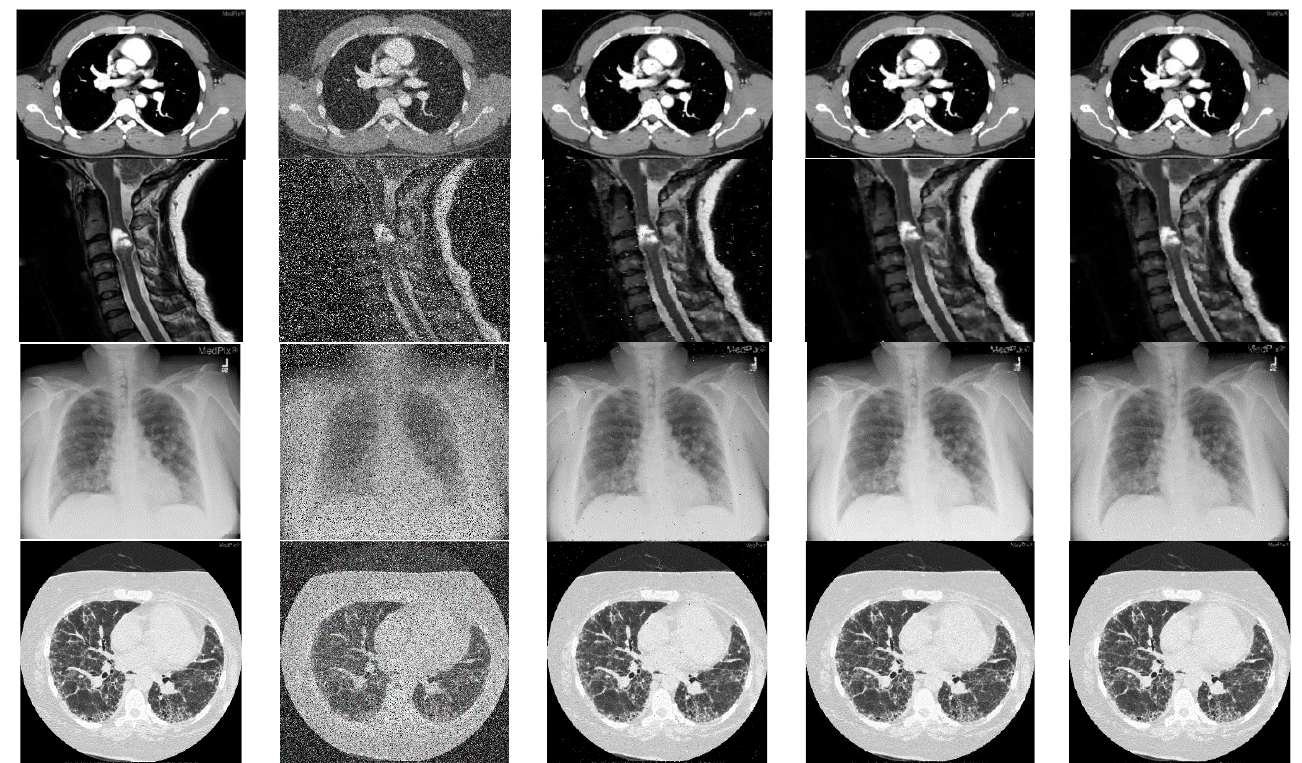
Figure 10. Shows image restoration results on medical image dataset. 1st column are the original images from MedPix database, 2nd column are the noisy images with 40% RVIN, third column shows de-noised results using AFIDM filter, fourth column shows de-noised results using QSAF and fifth column shows restoration results of proposed filter.